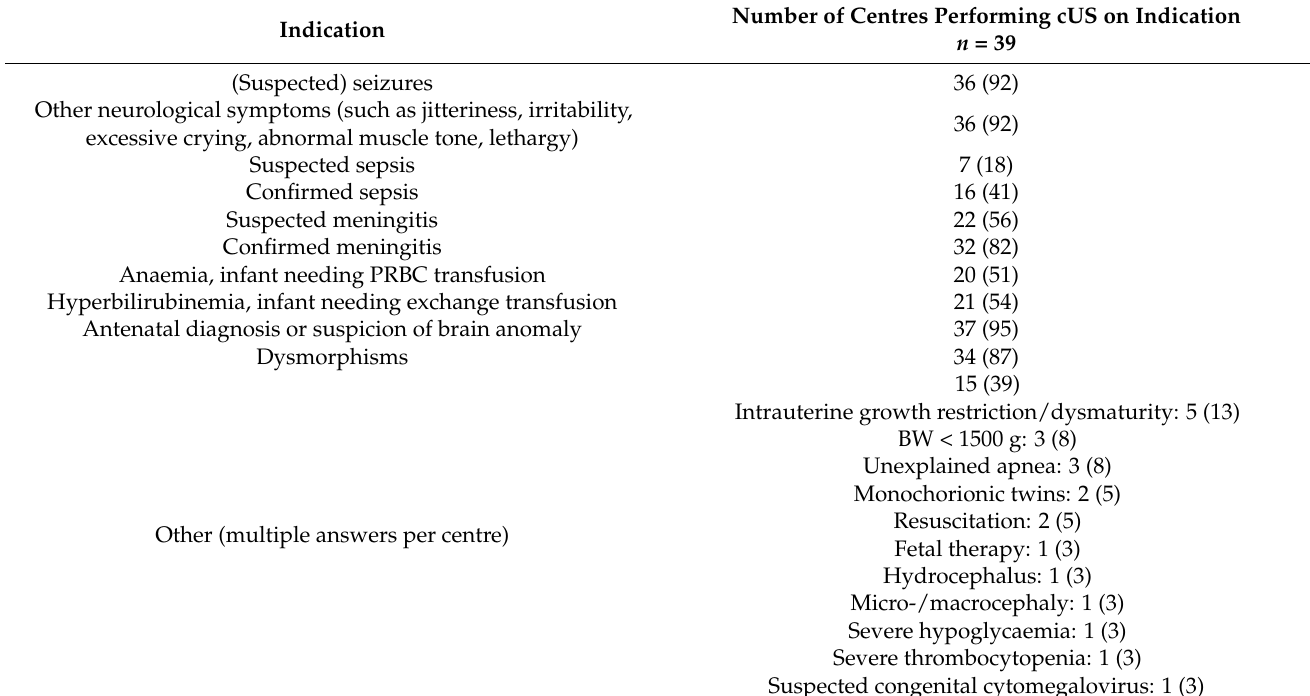
Table 2. Indications for cUS in MLPT